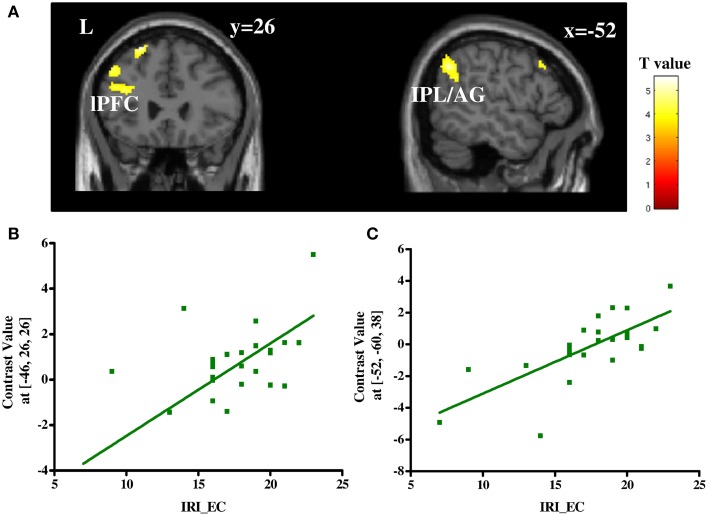
Correlation between the contrast of help vs. punish and IRI_EC scores (A) and plots of the positive correlation between IRI_EC scores and contrast values in local peak voxel of left lPFC (B) and that of left IPL/AG (C). IRI_EC, empathic concern subscale of interpersonal reactivity index scale; lPFC, lateral prefrontal cortex; IPL, inferior parietal lobule; AG, angular gyrus.